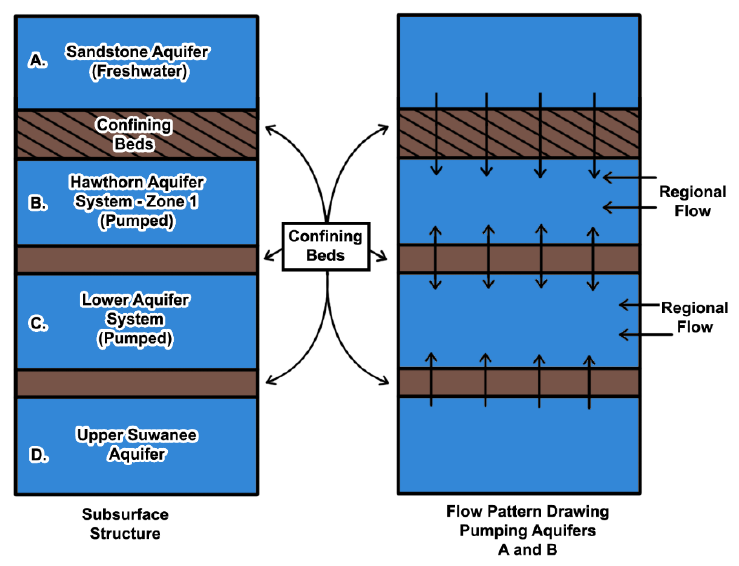
Figure 10. Conceptual model for the South Collier BWRO Plant Wellfield.